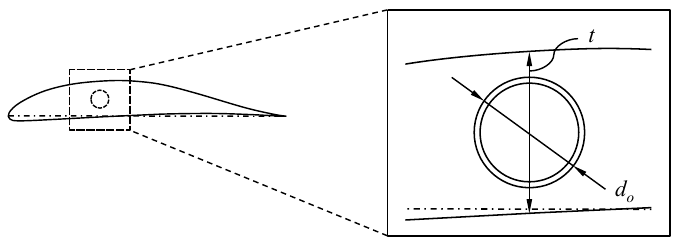
Figure 15. Defining the spar’s outer